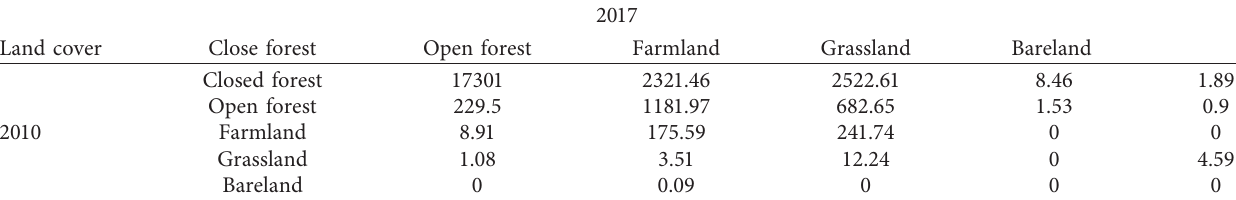
Table 13: Forest cover trends in hectares (ha) for FRs dangerously within community access.